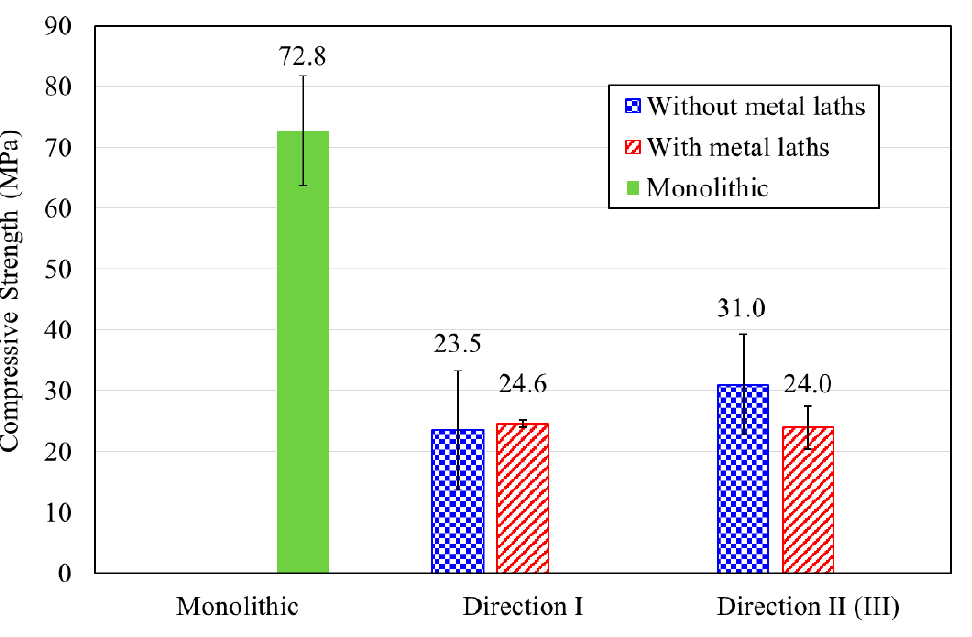
Figure 8. Compressive test results.